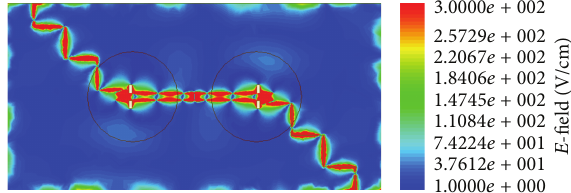
Figure 9: E -field distribution on top aluminum layer with 𝐿 1 = 14mm, 𝑊 1 = 10mm, 𝐿 2 = 11.68 mm, 𝑊 2 = 5.82 mm, 𝑆 off = 0.06 mm, 𝐶 𝐶 = 13 𝜇 m, 𝑊 = 0.19 mm, 𝐺 = 20 𝜇 m, 𝐿 𝑠 = 0.75 mm, 𝑊 𝑠 𝐿 = 1mm, th = 0.103 mm, 𝐿 = 0.417 mm, 𝐶 off = 0.16mm, and 𝑃 𝑤 = 0.01 stub